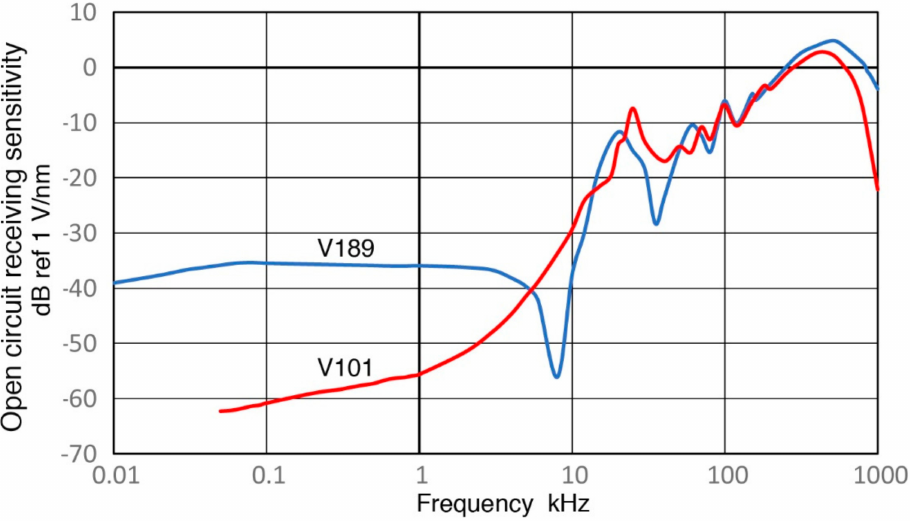
Figure 19. A comparison of two open-circuit receiving sensitivity spectra for V189 (0.5: blue) and V101 (0.5: red). Log-frequency